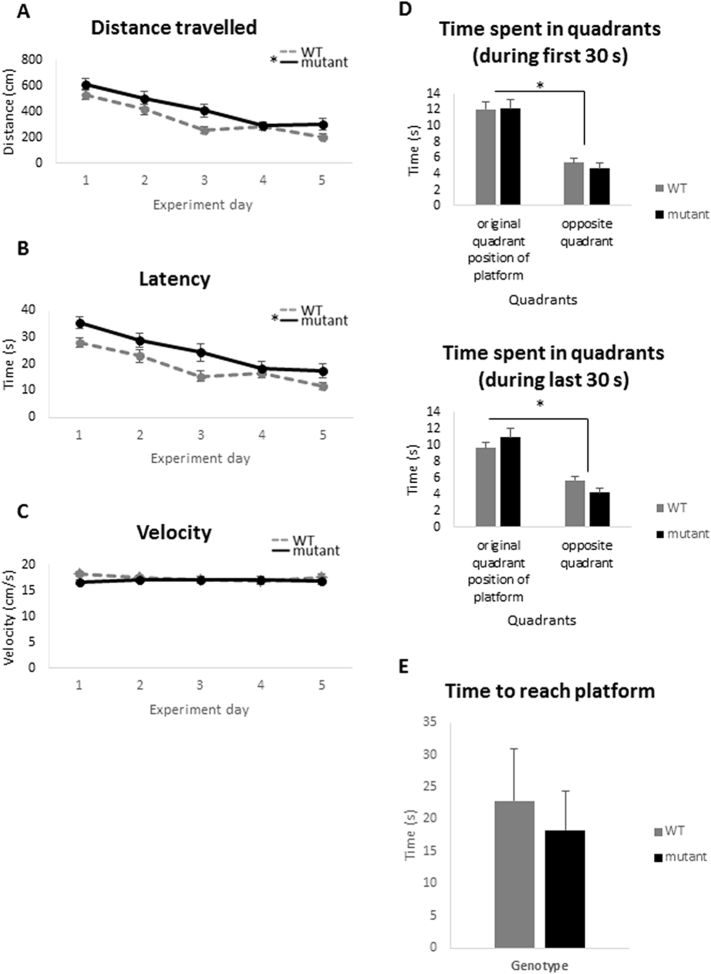
Performance of Zdhhc9 mutant and WT mice in the Morris water maze. Distance moved (A), latency (B) and mean velocity (C) during the 5 acquisition days of the experiment are shown. Statistics were conducted using general linear model, repeated measures in SPSS version 22 with experiment day as the within-subjects factor and genotype as the between-subjects factor; F(1,44) = 8.935, p = .005 for effect of genotype on distance moved, F(4,176) = 27.647, p < .001 for effect of day on distance moved while no interaction was found between day and genotype with F(4,176) = 1.020 and p = .399. F(1,44) = 9.677, p = .003 for effect of genotype on latency, F(4,176) = 23.499 and p < .001 for effect of day on latency while no interaction was found between day and genotype with F(4,176) = 0.868 and p = .484 (n = 26 WT, 20 mutant). The effect of genotype on velocity was non-significant. (D) Time spent in quadrants during the first 30 s and last 30 s of the probe trial to assess reference memory are shown. Statistics were conducted using general linear model, repeated measures in SPSS version 22; F(1,44) = 49.573, p < .001 for effect of quadrant during the first 30 s and F(1,44) = 41.805, p < .001 for effect of quadrant during the last 30 s (n = 26 WT, 20 mutant). (E) Time spent to reach the visible platform for WT and Zdhhc9 mutant mice during the visual cue trial of Morris water maze. Statistics were conducted using unpaired t-test in Minitab version 17; t(42) = −0.92, p = ns for effect of genotype (n = 26 WT, 20 mutant).